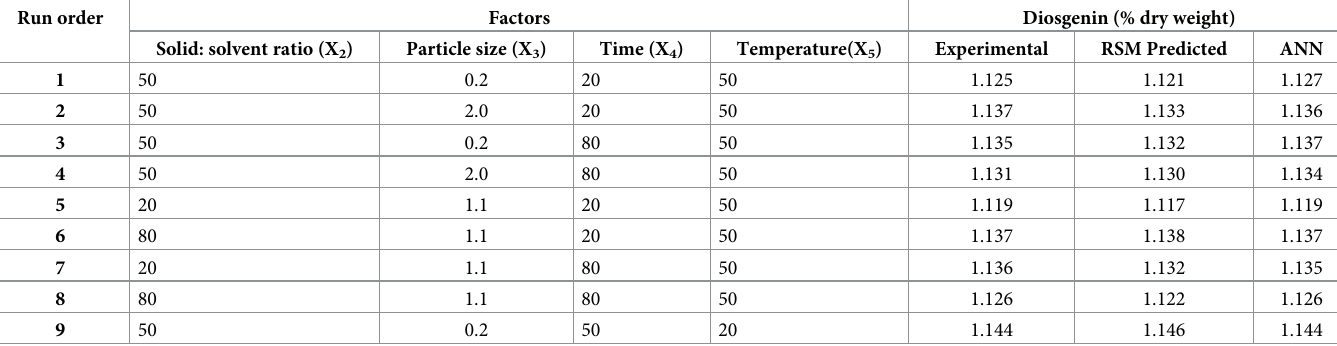
Table 10. Validation data set for extraction variables with corresponding experimental and predicted value (RSM and ANN). Run order Solid: solvent ratio (X 2